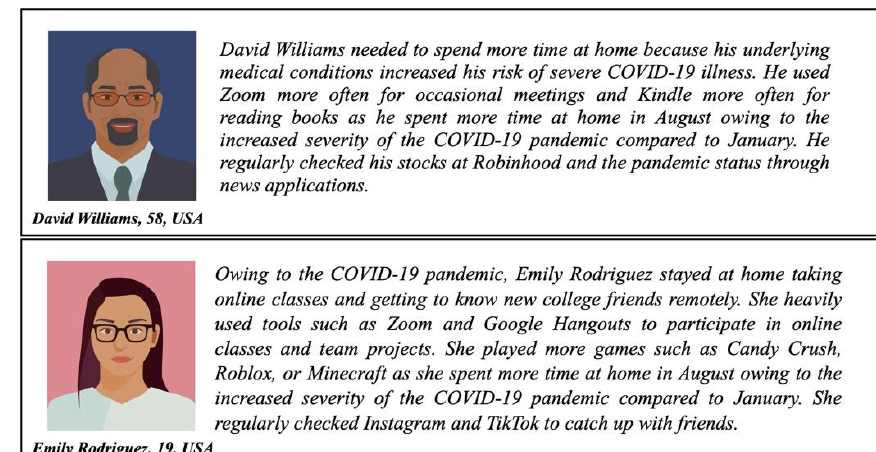
Figure 6. Four different types of personas in August 2020 constructed through analysis of data from January and August 2020. Table 1. Top 100 applications in January and August 2020.